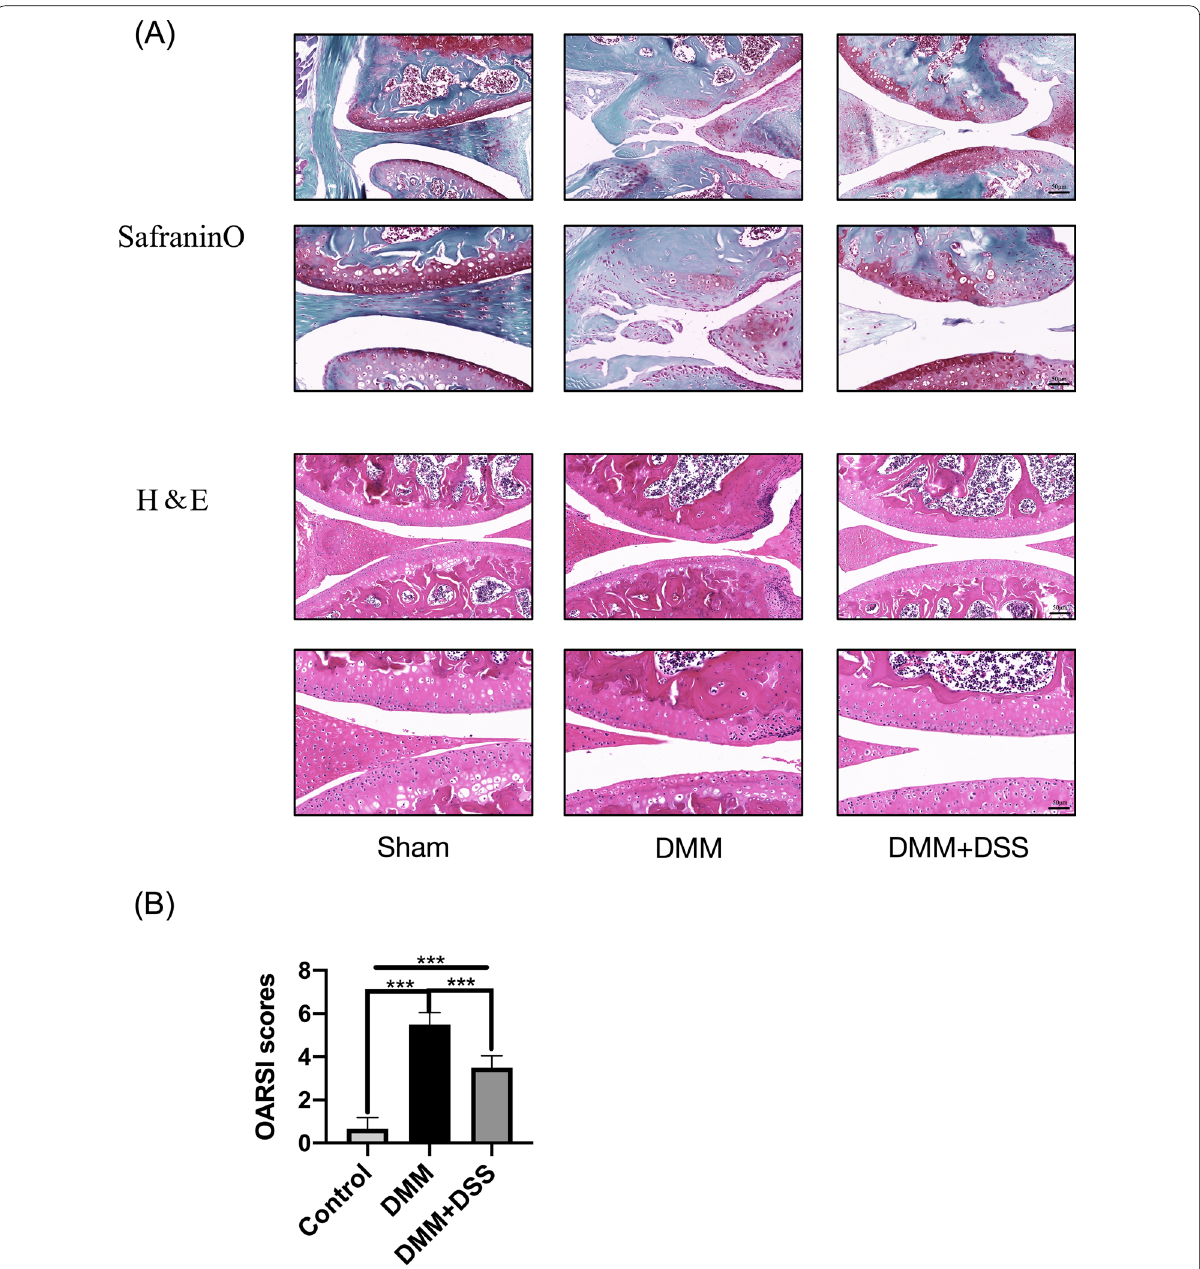
Fig. 5 DSS attenuated OA progression in mice model. A Representative images of safranin O and H&E staining of cartilage sections from different groups. B The cartilage OARSI scores of different groups. Scale bar